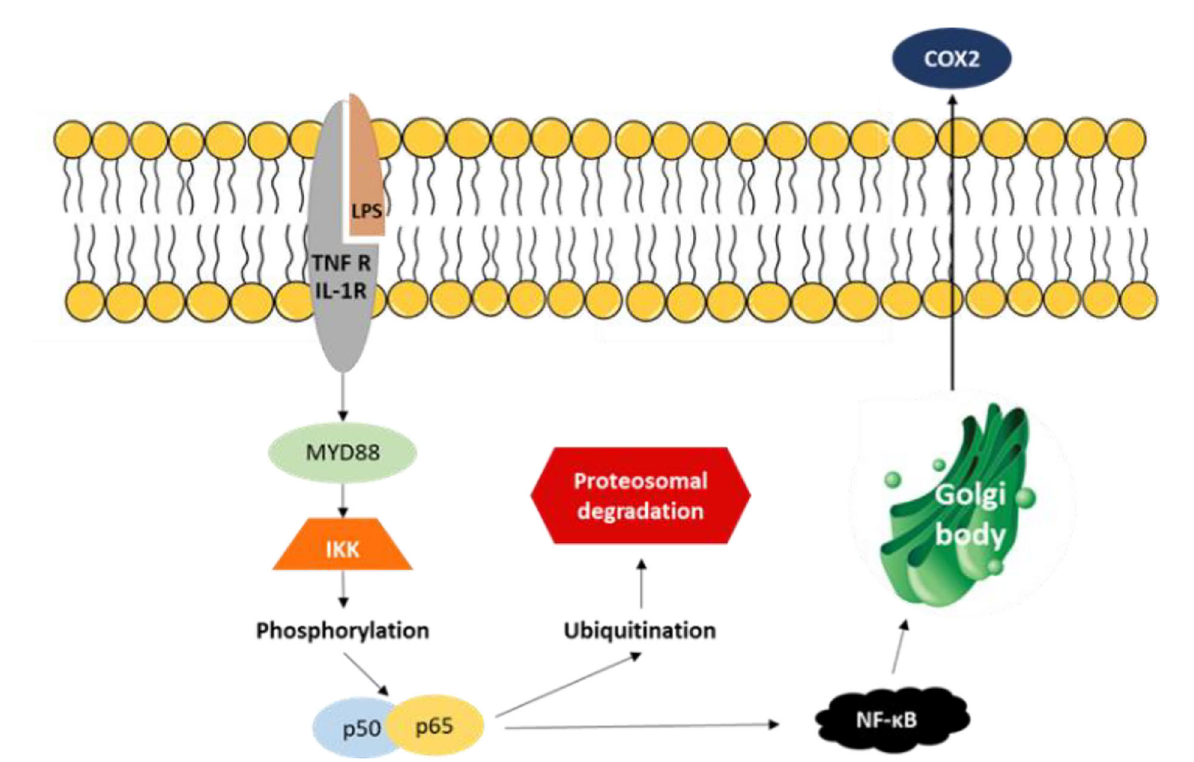
FIGURE3 TNF R, tumor necrosis factor receptors; TLR ligands (class of proteins that play a key role in the innate immune system); LPS, lipopolysaccharides; IL-1R, interleukin-1 receptor; MYD88—innate immune signal transduction adaptor—provides instructions for making a protein involved in signaling within immune cells; NF- κ B is a major transcription factor, essential for inflammatory responses, that regulates genes responsible for both the innate and adaptive immune response; IKK (classical Kinases responsible for the activation of NF- κ B); p50 and p65, subunits of NF-kappa B; COX2, enzyme inhibitor that suppresses inflammatory pathways; proteasome degradation: protein complexes that degrade unneeded or damaged proteins by proteolysis; ubiquitination: a protein is inactivated by attaching a single-chain polypeptide (ubiquitin) to